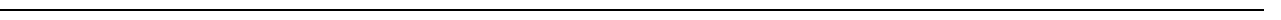
Fig. 3 US9 targets STING – TBK1 signaling axis to inhibit IFN- β signaling. a US9 colocalizes with STING as aggregates. HEK293T cells expressing STING-Myc were transfected with control vector (pEGFP-N3) or HA-US9-GFP. Cells were stained with anti-Myc antibody, followed by AlexaFluor 568-conjugated antibody. The nuclei were stained with DAPI. Scale bars, 10 μ m. b , c US9 colocalizes with endogenous STING and TBK1. HFF cells stably expressing control vector or HA-US9-GFP were stimulated by transfecting with salmon sperm DNA (dsDNA) (1 μ g ml − 1 ) for 12 h. Cells were stained with anti-STING ( b ) or anti-TBK1 ( c ) antibodies. The nuclei were stained with DAPI. Scale bars, 10 μ m. d US9 interacts with endogenous STING and TBK1. HFF cells stably expressing control vector or HA-US9-GFP were stimulated by transfecting with salmon sperm DNA (dsDNA) (1 μ g ml − 1 ) for 12 h. Cells were lysed and immunoprecipitated with anti-HA antibody, followed by immunoblotting with the indicated antibodies. e US9 disrupts the STING – TBK1 interaction. HEK293T cells expressing STING-Myc and Flag-TBK1 were transfected with or without HA-US9-GFP. For the immunoprecipitation assay, cells were lysed and the lysates were immunoprecipitated with anti-Flag antibody prior to immunoblot analysis with the indicated antibodies. The right bar graph represents the percentage of immunoprecipitated STING with TBK1. * P < 0.005 (Student ’ s t test). f US9 inhibits STING dimerization and aggregation. HEK293T cells expressing STING-Myc with or without HA-US9-GFP were lysed and cell lysates were subjected to SDS-PAGE analysis to determine STING dimerization (top) or SDD-AGE analysis to determine STING aggregation (bottom) following immunoblotting with the indicated antibodies. Data are representative of three independent experiments and are presented as mean ± s.d. in